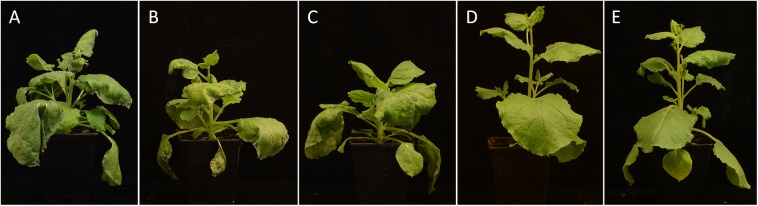
PpHLP is recognized by plant immune system. Nicotiana benthamiana plants were inoculated with PsyB728a wild-type strain (A) or strains carrying pBBR1-MCS2 derivatives, which express TTSS-mCherry (B), TTSS-RihA (C), HopQ1 (D), or TTSS-PpHLP (E). Disease symptoms developed only in control plants, that is plants treated with the wild-type PsyB728a, PsyB728a carrying plasmids encoding TTSS-mCherry or TTSS-RihA. The photographs were taken 7 days post-inoculation. The experiment was performed twice, with similar results.